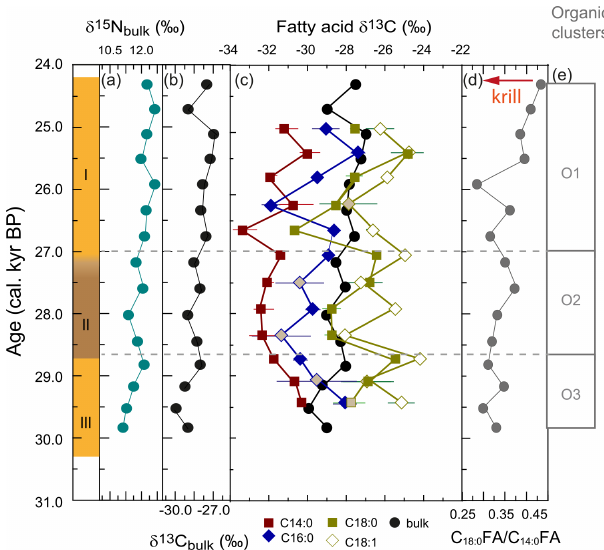
Figure 5. Stable isotope ratios in organic matter from stomach-oil deposit WMM7. The age model uses Holocene “no sea ice” (cid:49)R (Table 1). (a) Bulk δ 15 N; (b) bulk δ 13 C; (c) fatty acid δ 13 C and bulk δ 13 C. The standard deviations of replicates are shown: where no er- ror bar is visible the standard variation is smaller than the width of the symbol. Grey shaded data points are those for which the standard variation of the repeat measurements indicated poor repro- ducibility ( > 1‰). (d) C 18 : 0 / C 14 : 0 fatty acid ratio as an indica- tion of relative krill contribution, from Fig. 4; (e) cluster boundaries from Fig. 4.